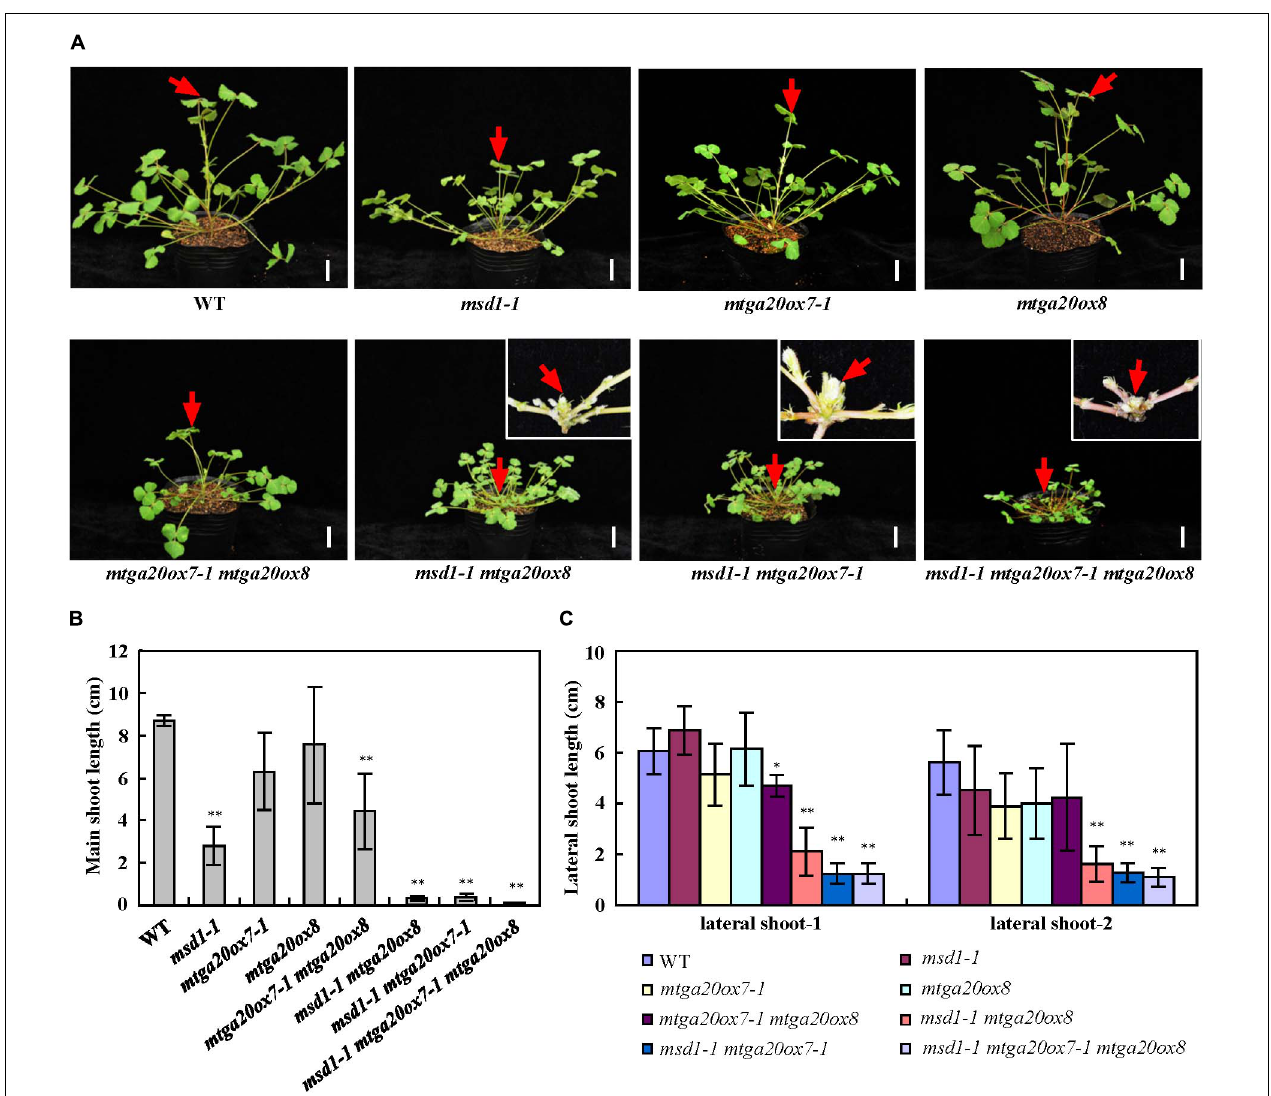
FIGURE 5 | Genetic analyses of MSD1 , MtGA20ox7 and MtGA20ox8 in regulating M. truncatula shoot elongation. (A) Phenotypic comparison of 4-week-old wild type (WT) and mtga20 mutants. Red arrows indicate main stem. The insets show close-up views of the main stem. Bars = 2 cm. (B) Comparison of the main shoot length in 4-week-old WT and mtga20 mutants. Bars represent means ± SD ( n = 16); asterisks indicate significant differences from the WT ( ∗∗ P < 0.01, Student’s t- test). (C) Comparison of the lateral shoot length in 4-week-old WT and mtga20 mutants. Bars represent means ± SD ( n = 16); asterisks indicate significant differences from the WT ( ∗ P < 0.05, ∗∗ P < 0.01, Student’s t-